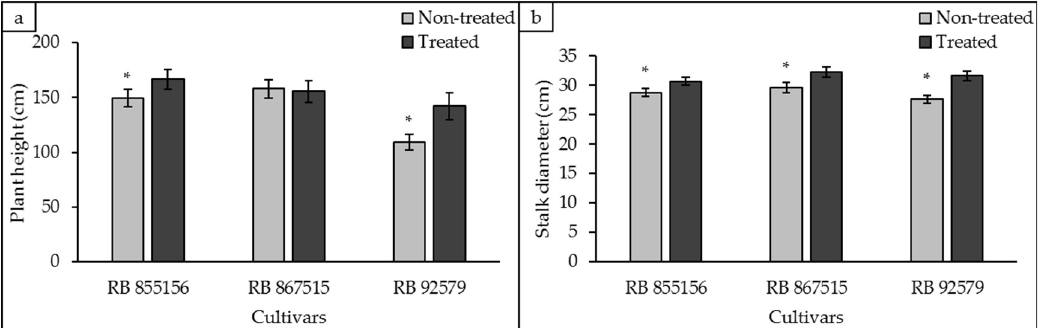
Figure 7. ( a ) Height and ( b ) stalk diameter of sugarcane plants treated with the fungicide, pyraclostrobin, in relation to control plants. The results represent the average of six evaluation times and three replications. * Indicates a significant difference among treatments by the Tukey test at 5% probability. The bar indicates the standard error of the mean.